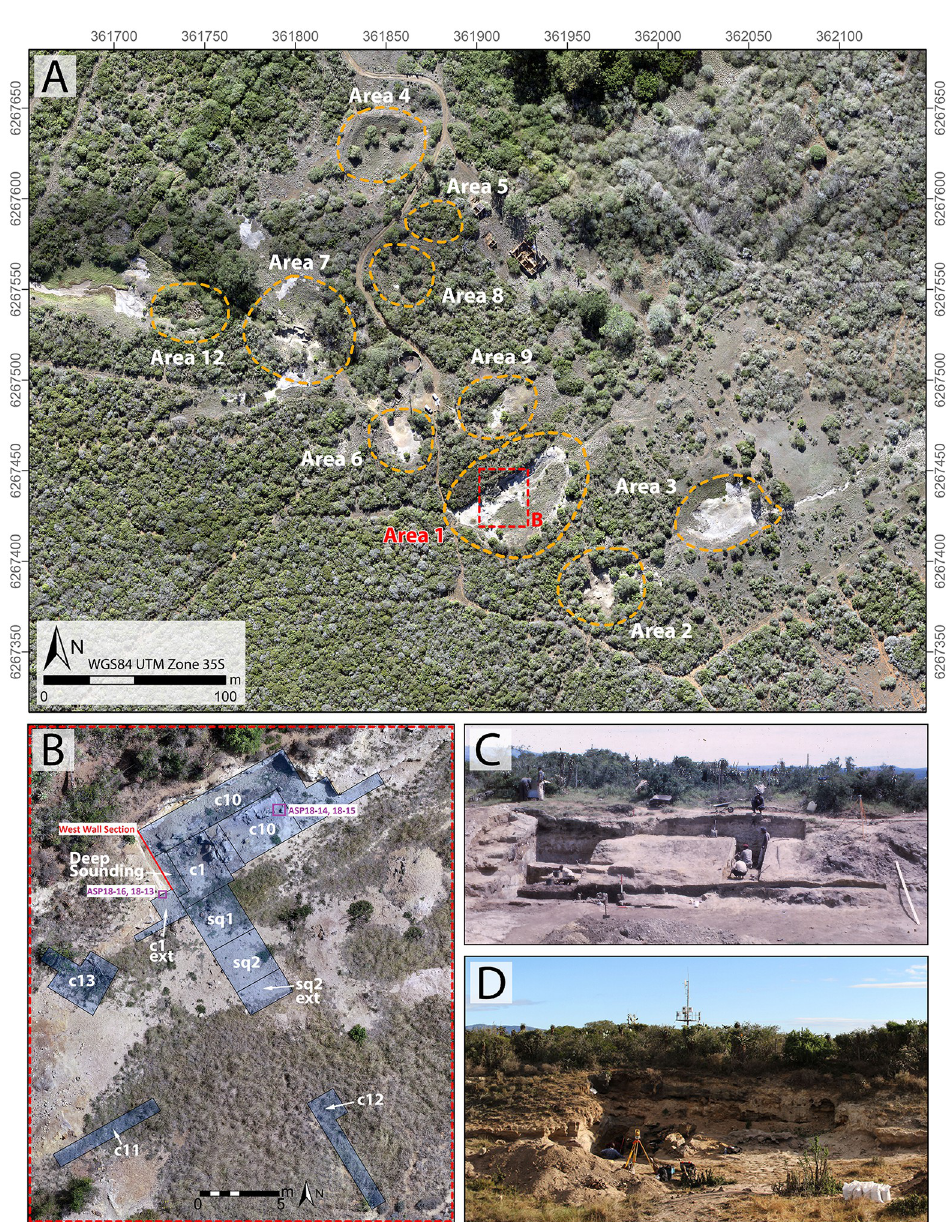
Fig 2. The Amanzi Springs site. A. Drone survey of Amanzi Springs showing the location of the various spring eyes, including Area 1; B. The Area 1 excavations of Deacon [10] showing the main excavation cuttings and squares, as well as luminescence dating locations and the location of the West Wall section shown in Fig 3; C and D, The Area 1 Cutting 1 and 10 excavations in the 1960s (C) and 2019 (D).